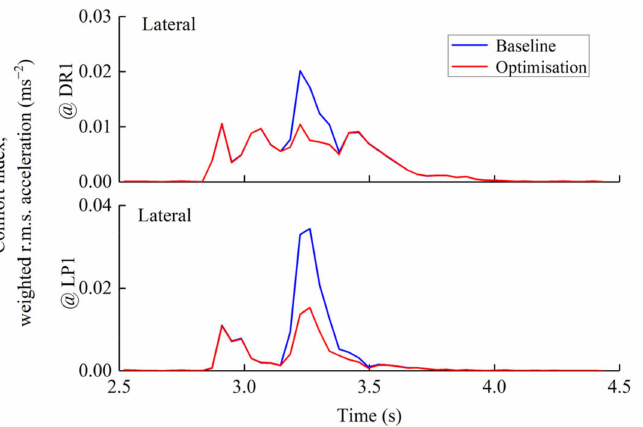
Figure 12. Comparison of lateral comfort indices at feet between the baseline and optimized